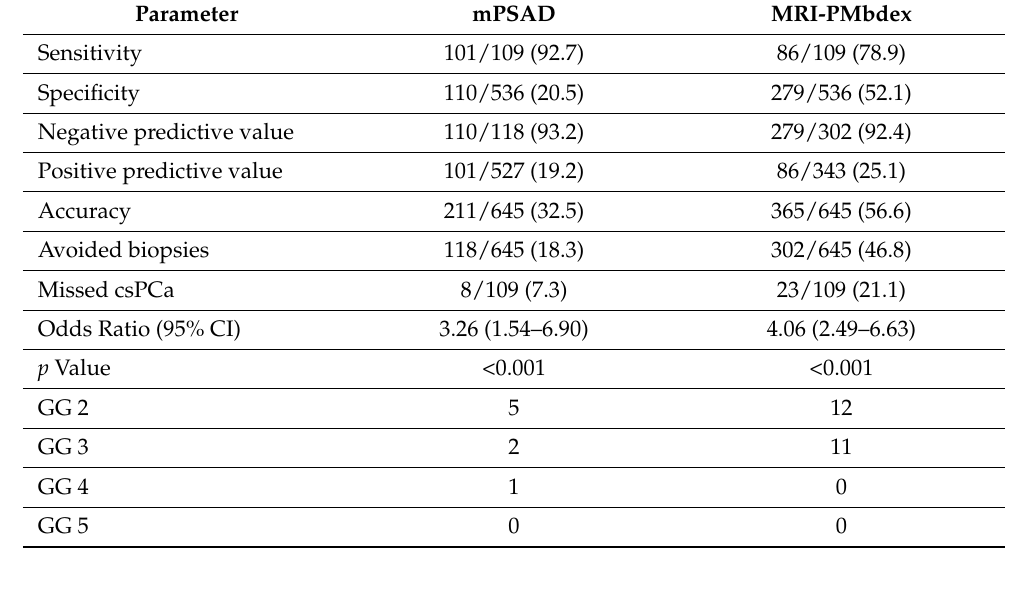
Table 5. Performance of mPSAD and MRI-PMbdex, with respective thresholds of 0.628 ng/mL 2 and 13.5%, in men with PI-RADS 3.